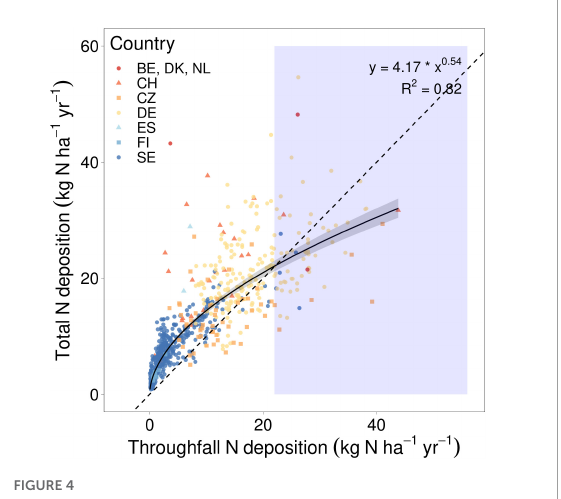
FIGURE4 Total N deposition regressed against throughfall N deposition after back-transformation to linear scales (univariate model). The solid line shows the regression. gray range 95% confidence interval. Dashed line: 1:1 line. Blue field: Range where the regression should not be used (TF > TD). BE, Belgium; DK, Denmark; NL, Netherlands; CH, Switzerland; CZ, Czech Republic; DE, Germany; ES, Spain; FI, Finland; SE, Sweden.